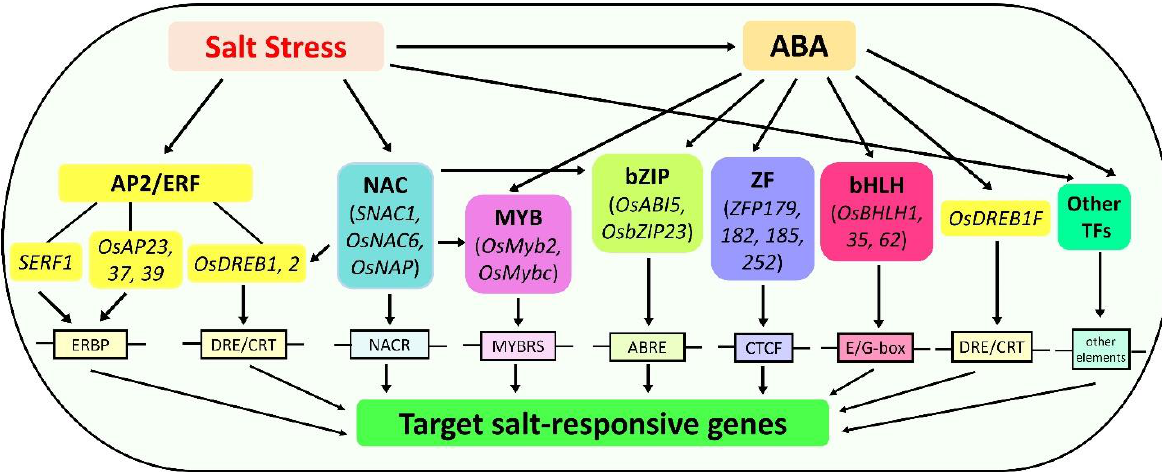
Figure 2. Transcriptional regulation involved in activating salt stress-responsive genes in rice. The transcriptional regulation occurs via abscisic acid (ABA)-dependent and -independent pathway, whereby transcription factors (TFs) bind with their corresponding cis -regulatory element. The APETALA2/ethylene responsive factor (AP2/ERF) and NAC (NAM, ATAF, and CUC) TFs operate in an ABA-independent pathway. NAC TFs regulate other TFs, such as dehydration responsive element-binding (DREB), myeloblastosis (MYB), and basic leucine-zipper (bZIP). The MYB, bZIP, zinc finger (ZF), basic-helix-loop-helix (bHLH), DREB, and other TFs are involved in the ABA-dependent pathway.